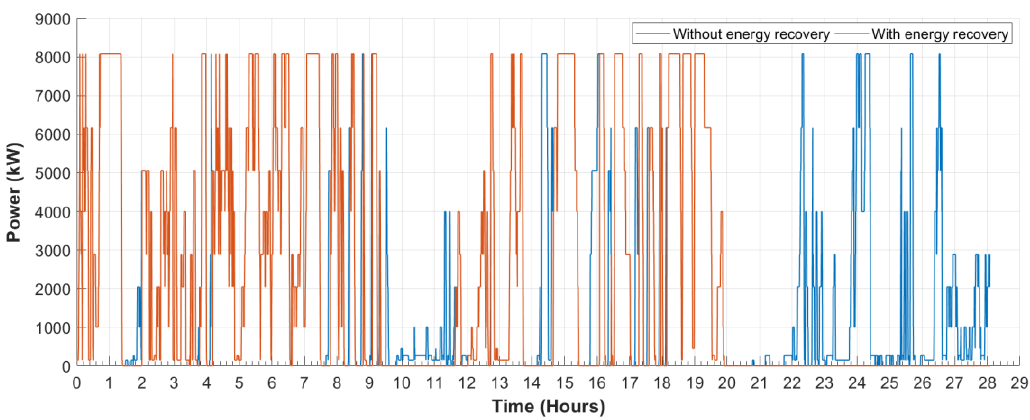
Figure 5. Demand profile with and without energy recovery (part of the trip).